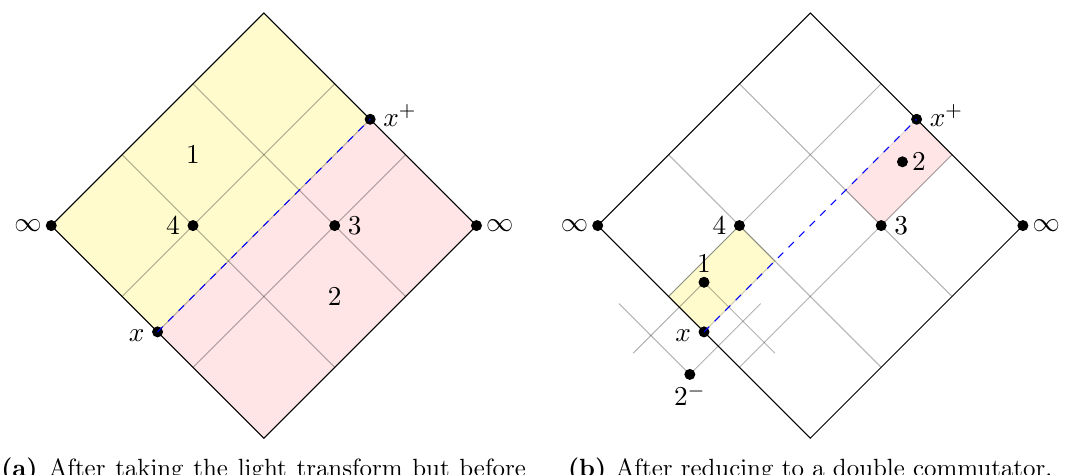
Figure 9. The con(cid:12)guration of points within the Poincare patch of x 1 at various stages of the derivation. The blue dashed line shows the support of light transform of O ( x; z ). The yellow (red) shaded region shows the allowed region for 1 (2). In the right-hand (cid:12)gure, we indicate that x is constrained to satisfy 2 (cid:0) < x < 1. Note that after reducing to a double-commutator, the yellow and red regions are independent of x 1 (as long as x is lightlike from x 1